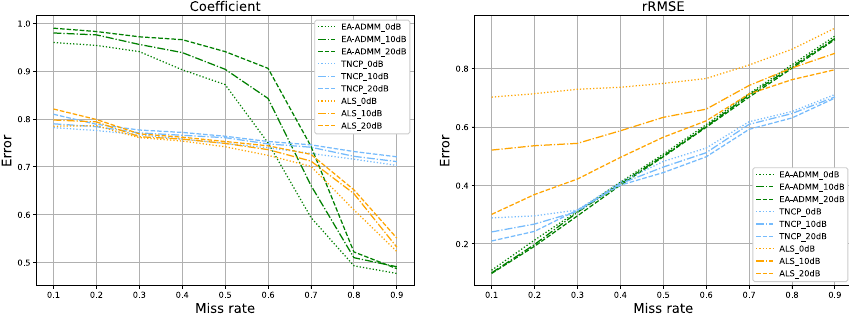
Fig. 6 Tensor completion performance when the missing rate varies from 0.1 to 0.9 and ˆ µ = 0